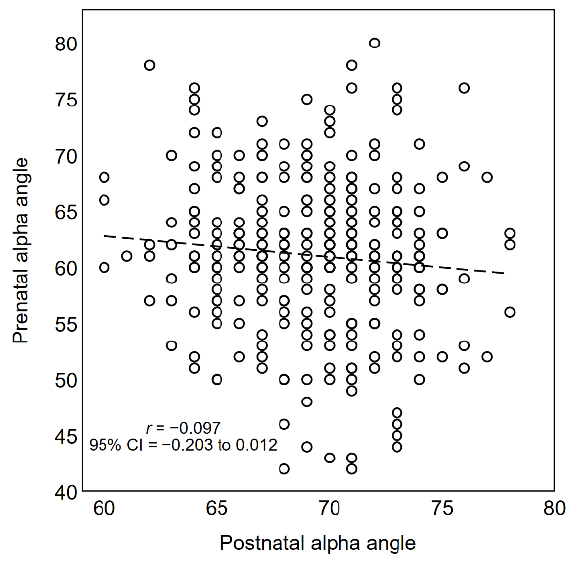
Figure 6. Scatter plot of alpha angles measured before and after birth ( n = 324). Dashed line indicates the linear correlation between the two measurements.